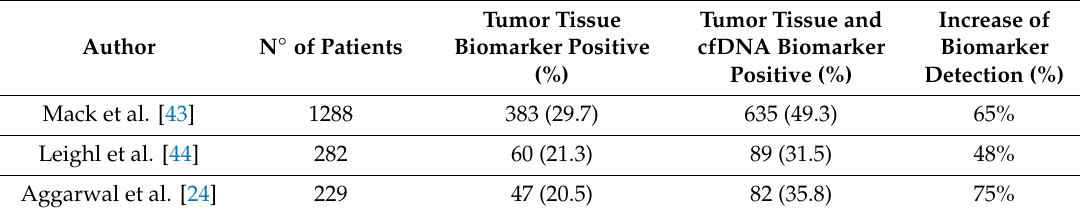
Table 3. Increase of NSCLC patients with at least one biomarker identified using cfDNA NGS analysis in addition to tumor tissue